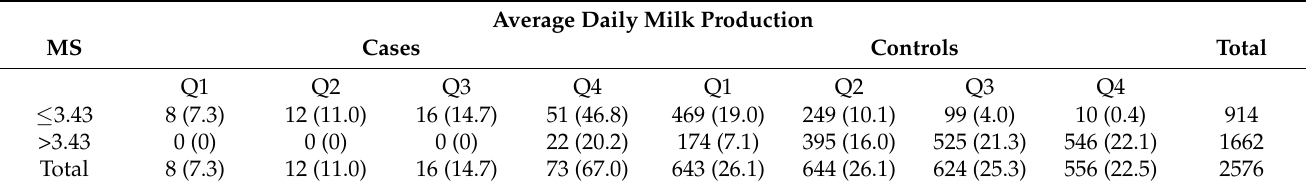
Table 2. Frequency distribution of dairy cows with (cases, n = 109) and without (controls, n = 2,467) repeated forced take-off stratified by average daily milk production categorized into 4 levels based on interquartile ranges (Q1, ≤ 34.9; Q2, 35–42.6; Q3, 42.7–49.4; and Q4, ≥ 49.5 kg/d) and milking speed (MS) categorized into 2 levels (low, ≤ 3.43 and high, >3.43 kg/min).